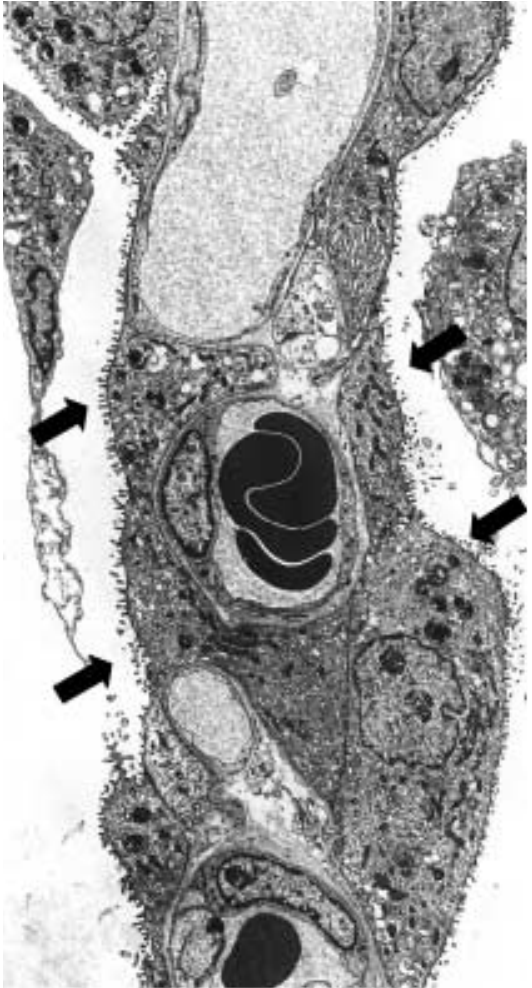
Electron microscopy of an alveolar septum of a patient who died of ALI/ARDS in the subacute, prolif- erative phase. There is evidence of re-ep- ithelialisation of the damaged epithelial barrier with hyper- plastic alveolar type II cells, resulting in coverage of the de- nuded basement membrane and re- establishment of the continuity of the alveolar epithelium.